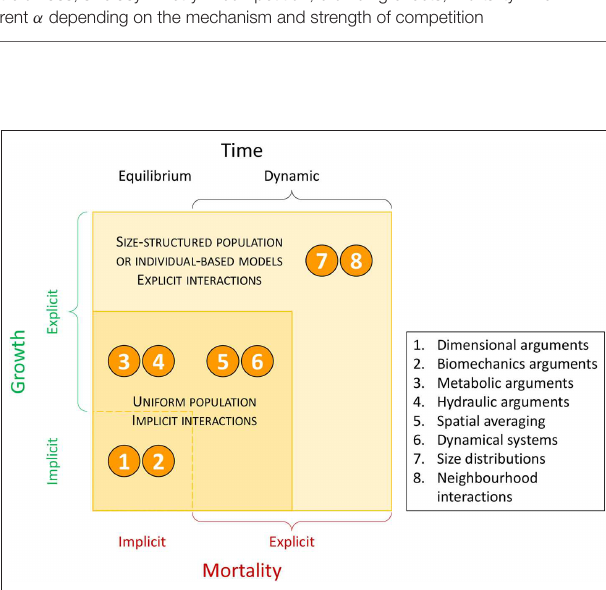
FIGURE 3 | The various mechanisms leading to the power-law relation w ( t ) C [ p ( t )] − α reviewed here. The mechanisms are grouped based on how = growth and mortality are treated and whether time, age class, and resource competition among individuals are explicitly considered. Note: in all temporally dynamic mechanisms, mortality is explicit. However, an explicit account of growth does not preclude an implicit account of